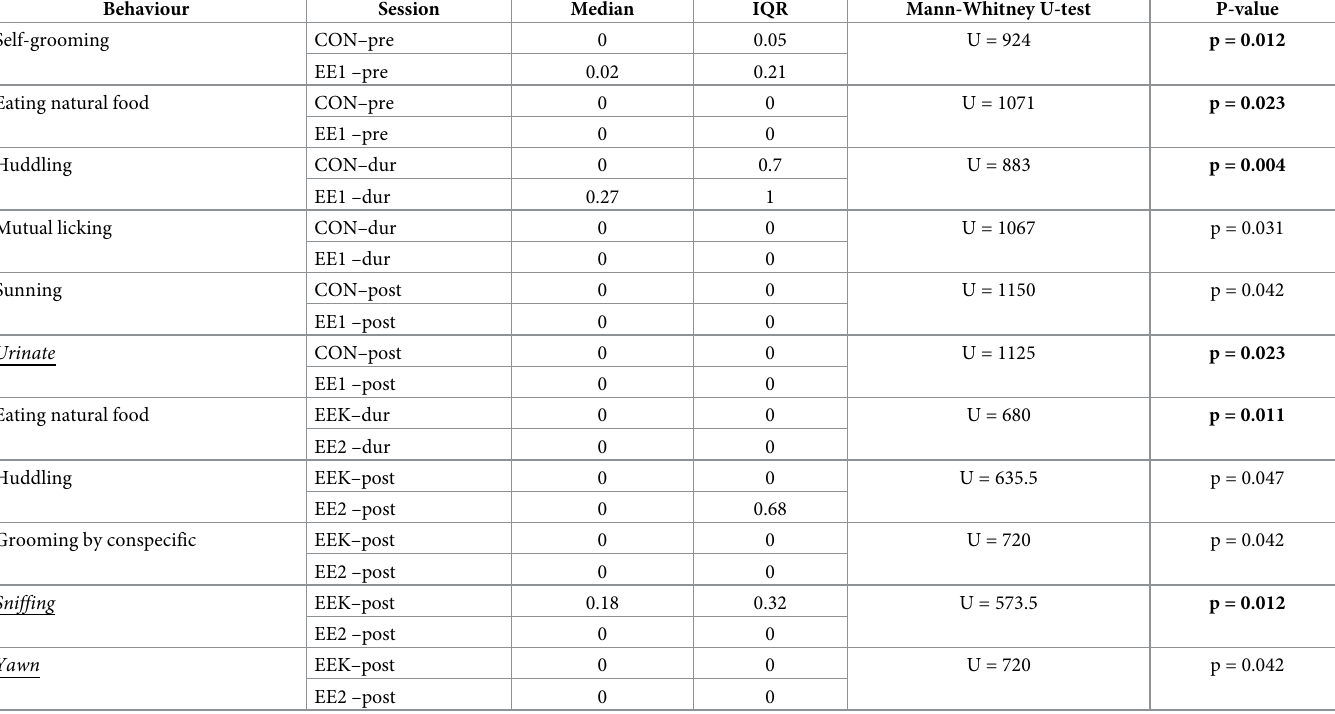
Table 1. Medians, interquartile range of the behaviours which resulted significantly different among sessions and Mann-Whitney U-test results. Behaviours in ital- ics indicate events. Only behaviours which significantly differed or showed a tendency to differ are reported. P -values not reported in bold are those which after Bonferroni correction are not significant but represent a tendency. Behaviour Session Median IQR Mann-Whitney U-test